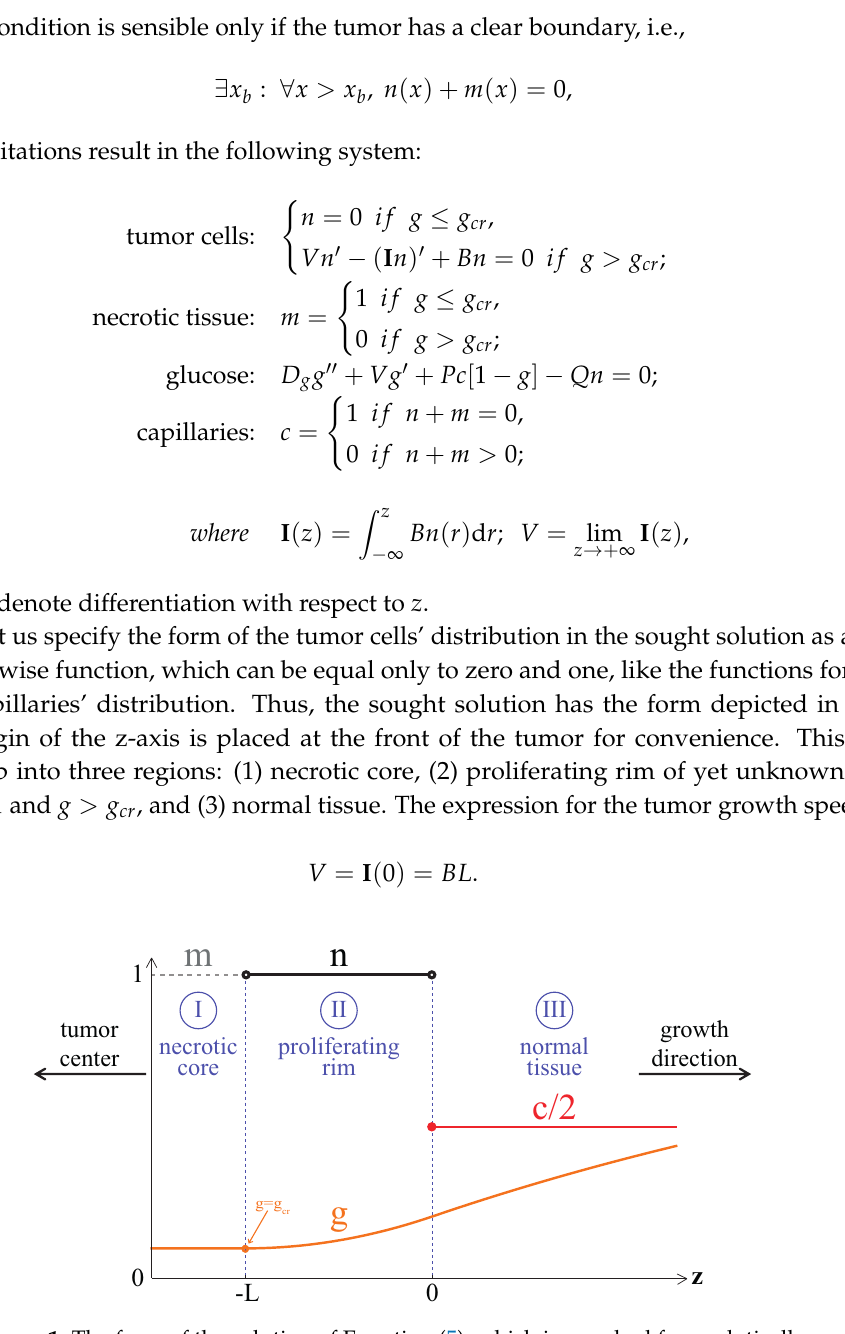
Figure 1. The form of the solution of Equation (5), which is searched for